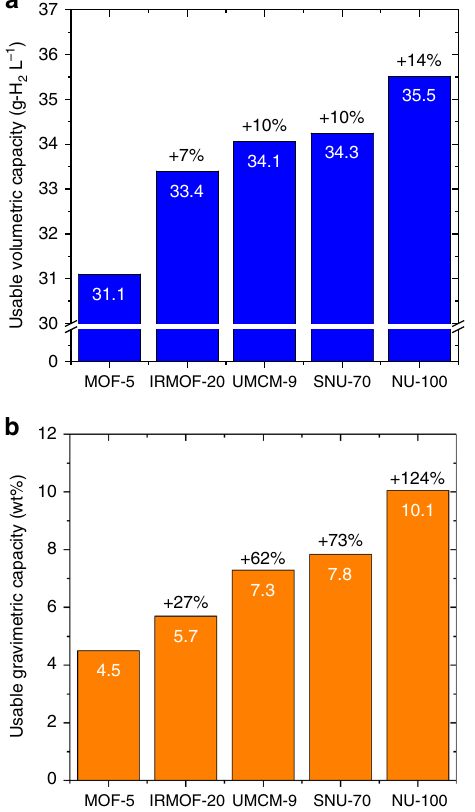
Fig. 4 Measured usable H 2 storage capacities of MOFs. a Volumetric basis and b gravimetric basis. Capacities are reported for an isothermal pressure swing at 77 K between 5 and 100 bar. Data for MOF-5 and IRMOF-20 are taken from ref. 1 . Percentages listed at the top of each bar correspond to improvements over